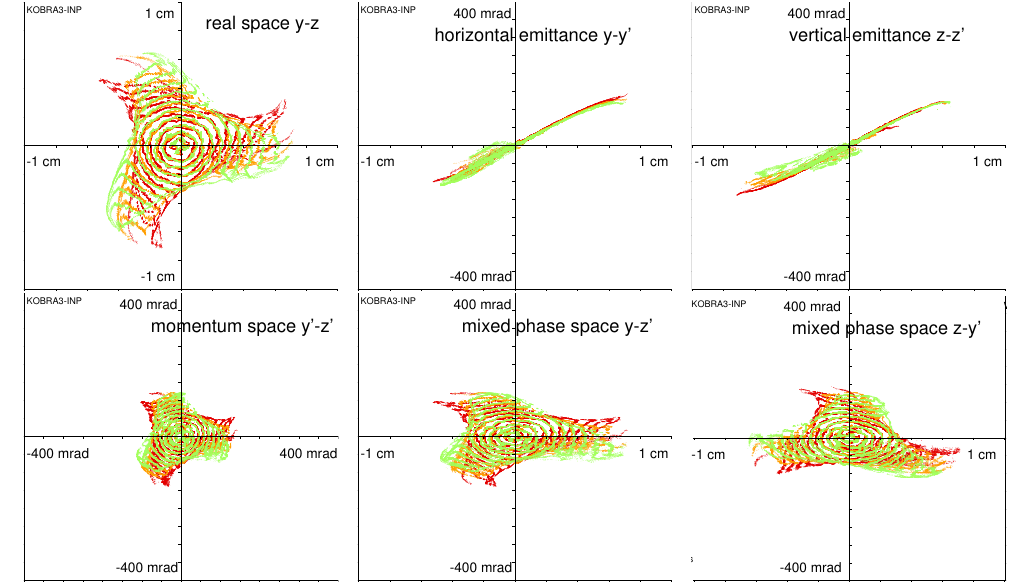
Figure 12. Different projections of the 6D-phase-space behind the extraction electrode (x = 0.45m in Figure5). Top row: real space, horizontal, and vertical emittance. Bottom row: momentum space, horizontal, and vertical mixed phase-spaces (horizontal angle against vertical position and vice versa). Scaling 1cm, 400mrad. Green: Ar + , brown Ar 2 + , and red Ar 3 + . Each of these six projections ± ± contains 465,688